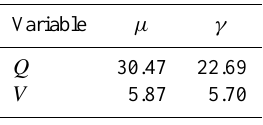
Table 2. Rank-based non-parametric measures of dependence: Spearman’s rho ( ρ ) and Kendall’s tau ( τ